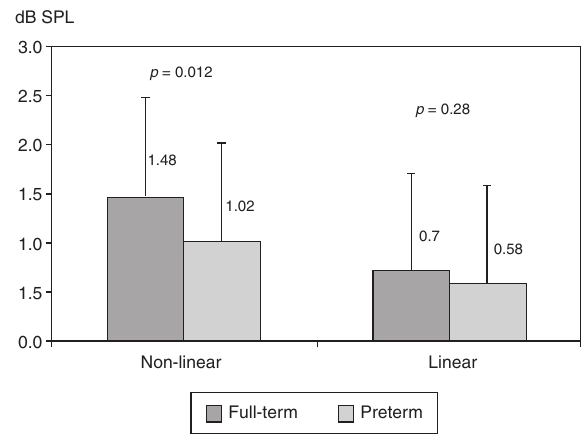
Figure 2 Efferent inhibitory effect: comparison between full-term vs. preterm newborns for linear and non-linear click- evoked stimuli (mean ±